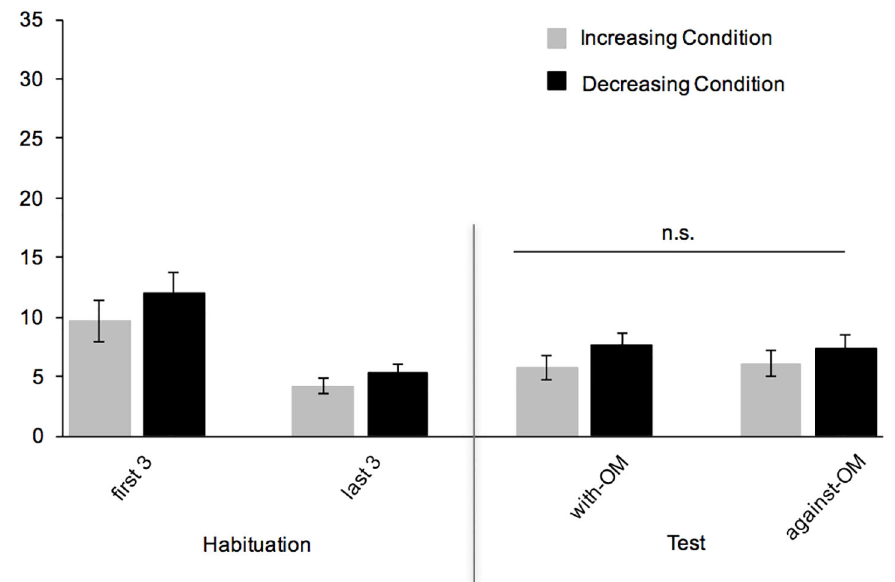
Figure 2. Overall mean total looking time (±SEM) to the first three and last three habituation trials, and to the with-OM and against-OM test trials displayed by infants in the increasing and decreasing order conditions in Experiment 1. Infants failed to show discrimination between the with-OM sequence and the against-OM